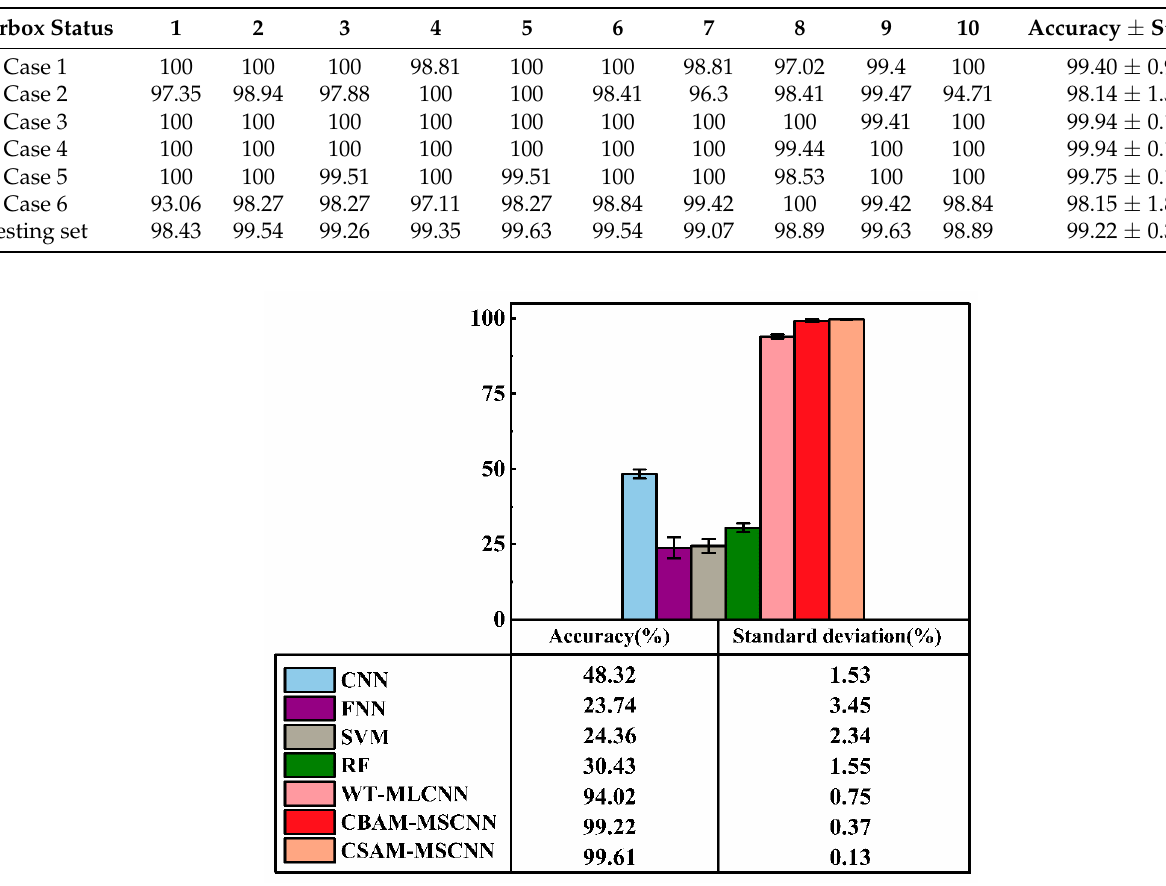
Figure 17. Comparison of accuracy and standard deviation between the CSAM-MSCNN and other models.